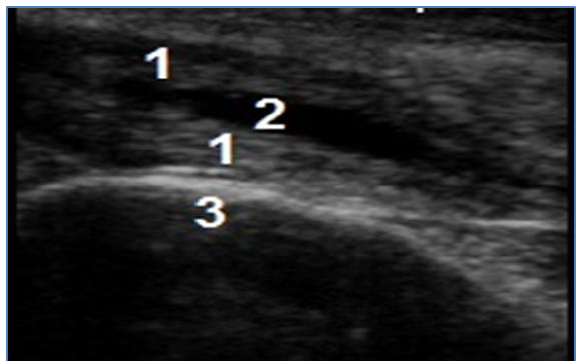
Figure, 6: Per-rectum ultrasonogram of urinary bladder of buffalo after urination. 6.5 MHz. 1=bladder wall, 2=hypoechoic urine, 3=pelvic bone. Cranial to the right.